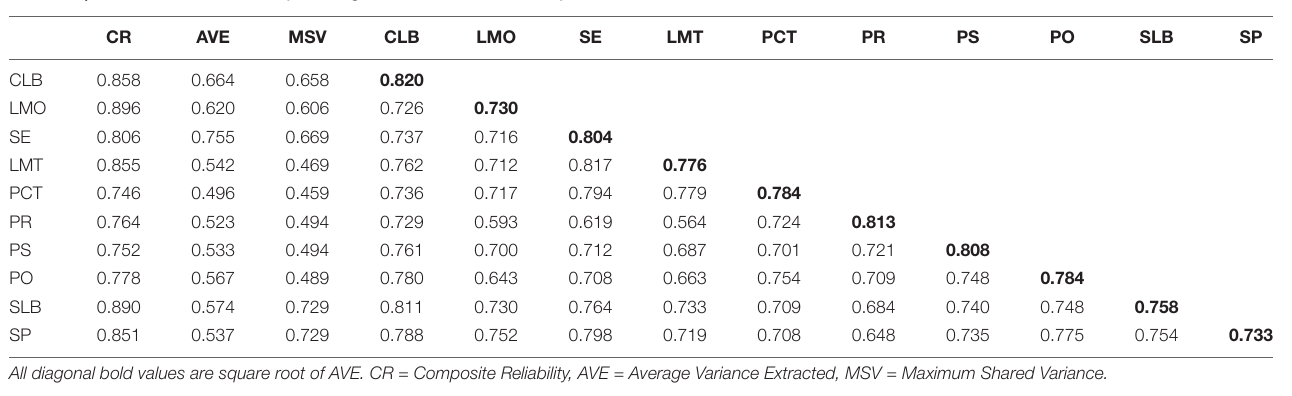
TABLE 5 | All dimensions of the study convergent and discriminant validity.